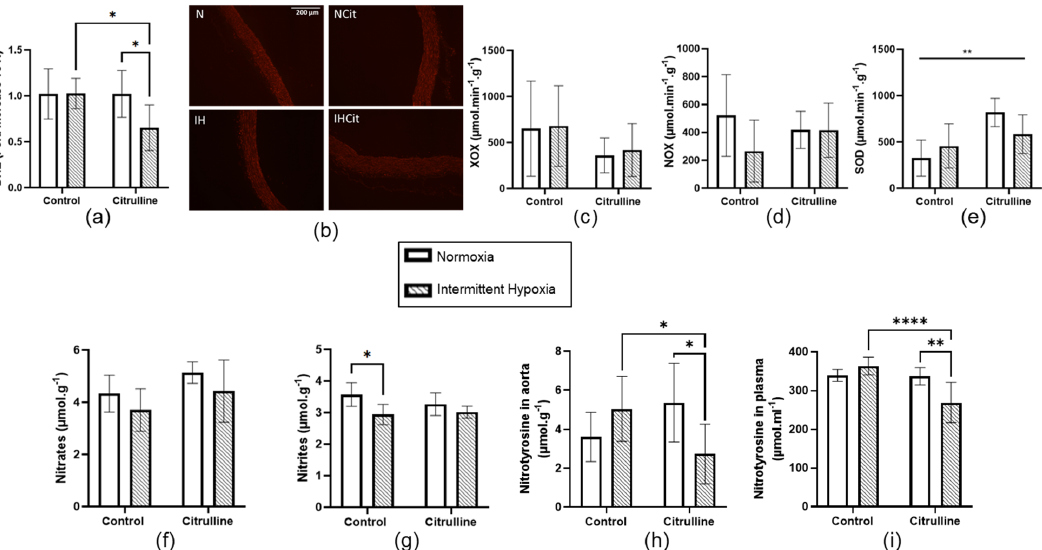
Figure 4. Citrulline decreased oxidative stress, nitric oxide derivatives, and nitrotyrosine levels in the aorta under intermittent hypoxia (IH). ( a ) DHE levels with ( b ) representative images ( × 100); Activities of ( c ) xanthine oxidase (XOX), ( d ) NADPH oxidase (NOX), and ( e ) superoxide dismutase (SOD) expressed in µ mol · min − 1 · g − 1 of protein ( n = 5–6); ( f ) nitrate, ( g ) nitrite and ( h ) nitrotyrosine levels in aorta expressed in µ mol · g − 1 ( n = 4–6) ( i ) Nitrotyrosine levels in plasma expressed in µ mol · ml − 1 ( n = 5–6) from rats exposed to normoxia (N) or IH supplemented with 1 g · kg − 1 · d − 1 citrulline (Cit) or not (Control). Values are represented as mean ± SD. Two-way ANOVA followed by Fisher’s LSD test. * p < 0.05, ** p < 0.01, **** p <